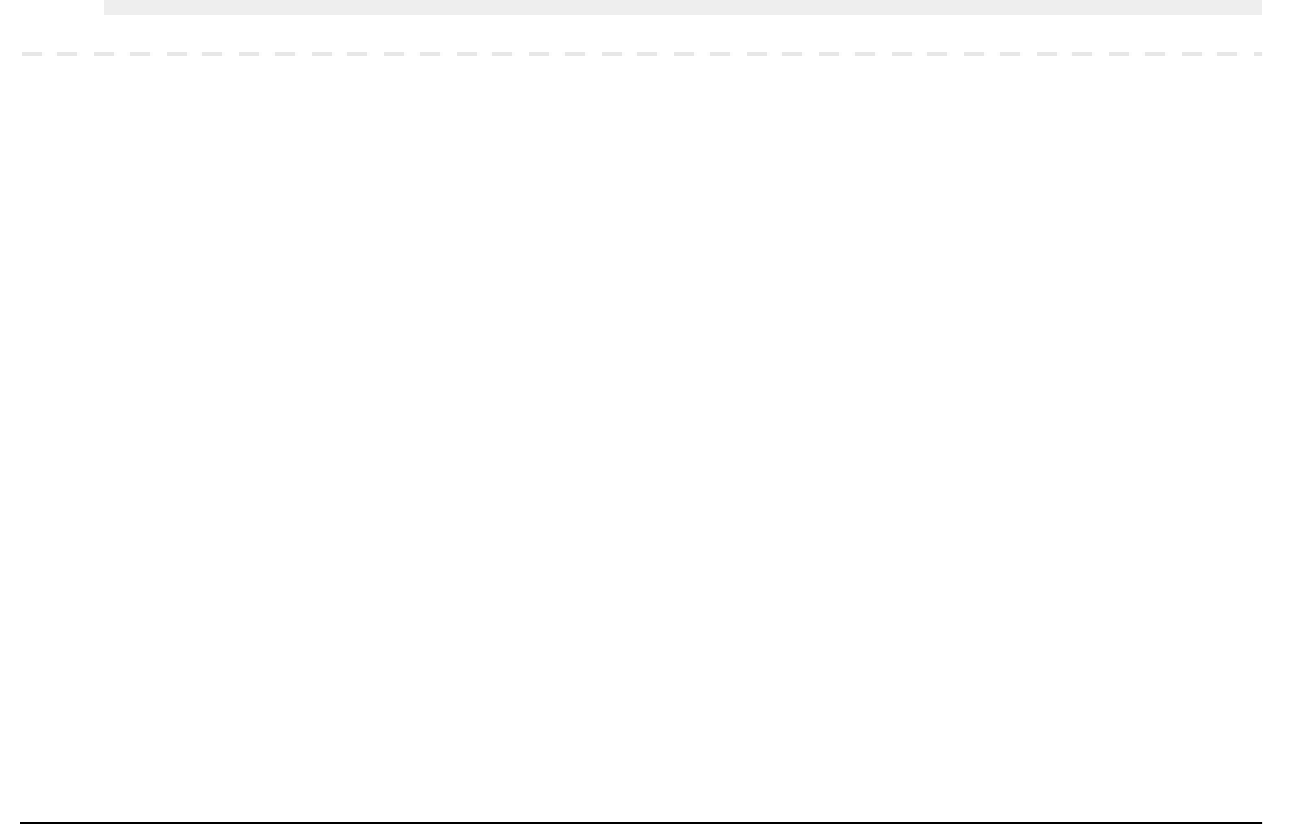
increase in infections attributable to this